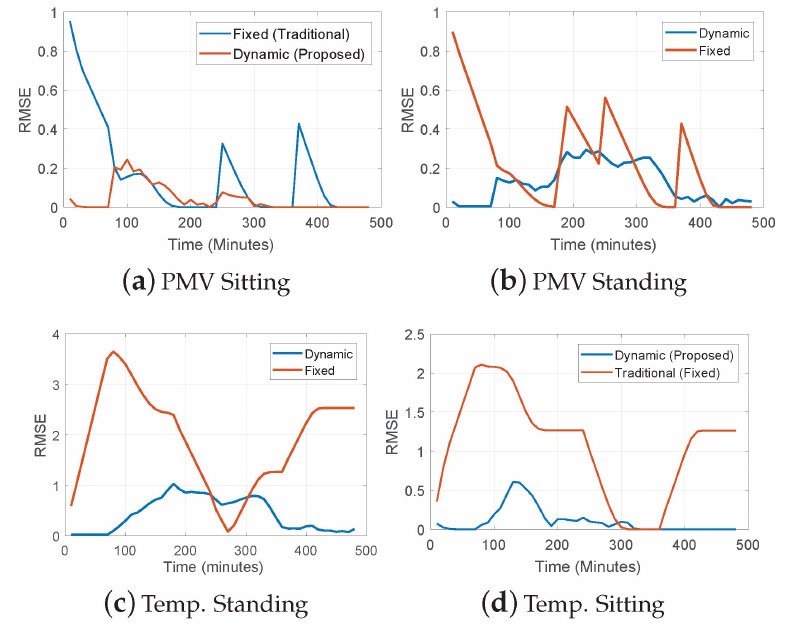
Figure 9. RMSE results comparing the adaptive (dynamic) model with a ground truth for various sitting activities for both PMV and temperature. Also shown are ’fixed’ results where a single PMV is assumed depending on whether the person is sitting or